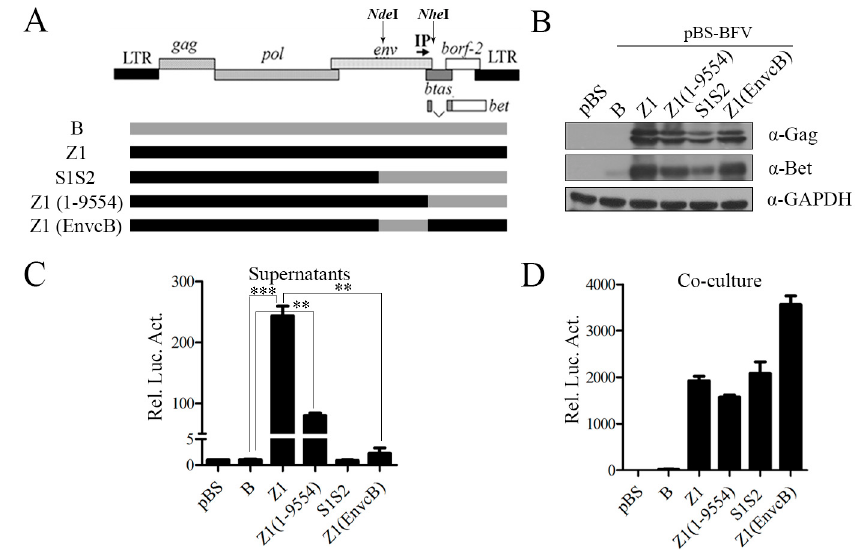
Figure 3. The C terminus of Env determines the ability of BFV to generate infectious cell-free particles. ( A ) We constructed clone BFV-Z1(1-9554) by the single restriction enzyme sites of Nhe I, which cuts downstream of Env in the BFV proviral genome, and clone BFV-Z1(EnvcB) was constructed by Nde I and Nhe I. The gray box represents the BFV3026 proviral genomic DNA of pBS-BFV-B, and the black box represents pBS-BFV-Z1. ( B – D ) BHK-21 cells (2 × 10 5 ) were transfected with 2 µ g empty vector pBS, pBS-BFV-B, pBS-BFV-Z1, pBS-BFV-Z1(1-9554), pBS-BFV-S1S2, or pBS-BFV-Z1(EnvcB) for 4 days, and cells were subjected to western blotting with indicated antibodies ( B ). The cell-free and cell-to-cell transmission activity was measured with the indicated assays ( C , D ), and the data were the averages of three independent experiments.